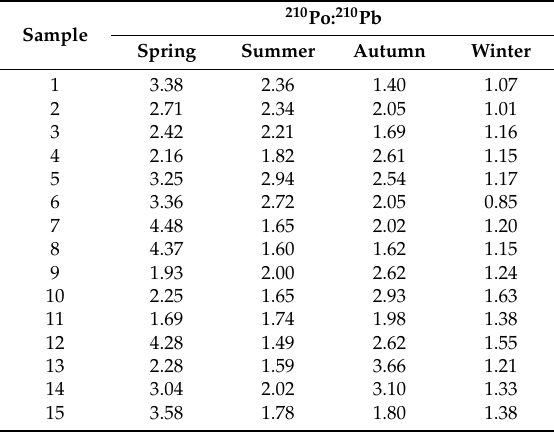
Table 3. The 210 Po: 210 Pb ratios in surface sediments from all sampling points. Sample